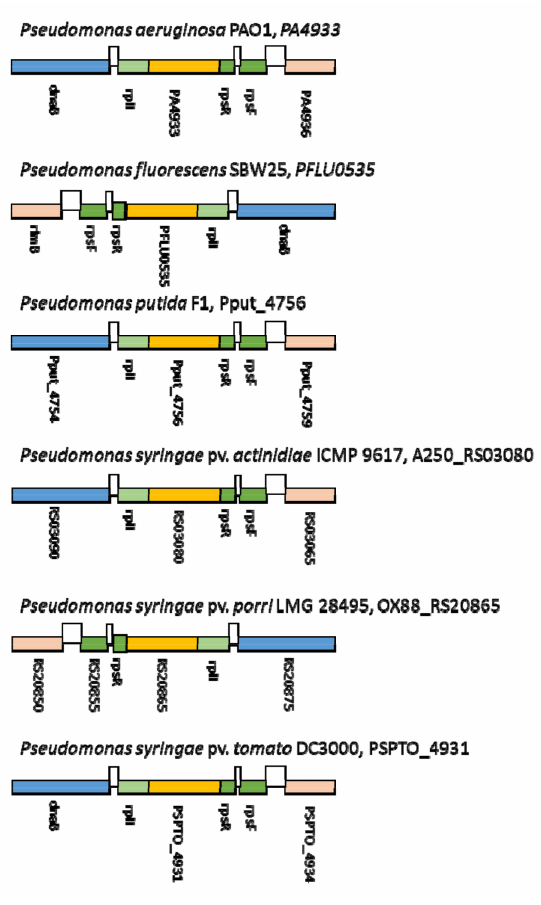
Figure A3. Genomic organization of the operon in which OX88_RS20865 homologues are located in six di ff erent Pseudomonads: Pseudomonas aeruginosa PAO1, Pseudomonas fluorescens SBW25, Pseudomonas putida F1, Pseudomonas syringae pv. actinidiae ICMP 9617, Pseudomonas syringae pv. porri LMG 28495, and Pseudomonas syringae pv. tomato DC3000. The di ff erent functions of the genes are indicated with colors: blue—DNA helicase, light green—50s ribosomal subunit, yellow—OX88_RS20865 homologue, dark green—30s ribosomal subunit, pink—rRNA methyltransferase, white—intergenic region (adapted from www.pseudomonas.com). Table A1. Overview of the knock-out mutants and the location of the Tn5 transposon as identified during the TAIL-PCR that are potentially involved in phage